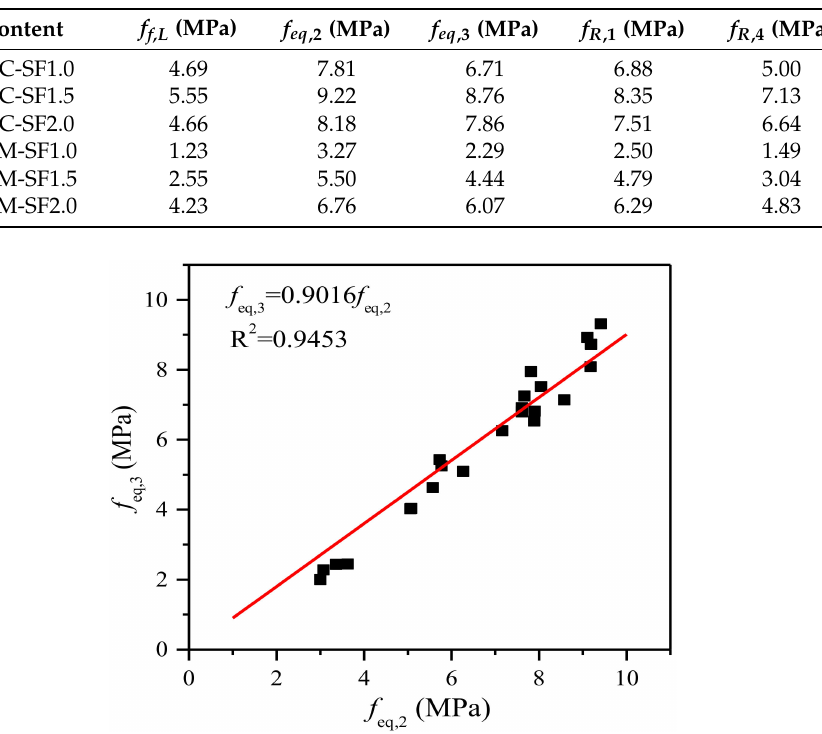
Table 6. TPB tests: flexural strength parameters.